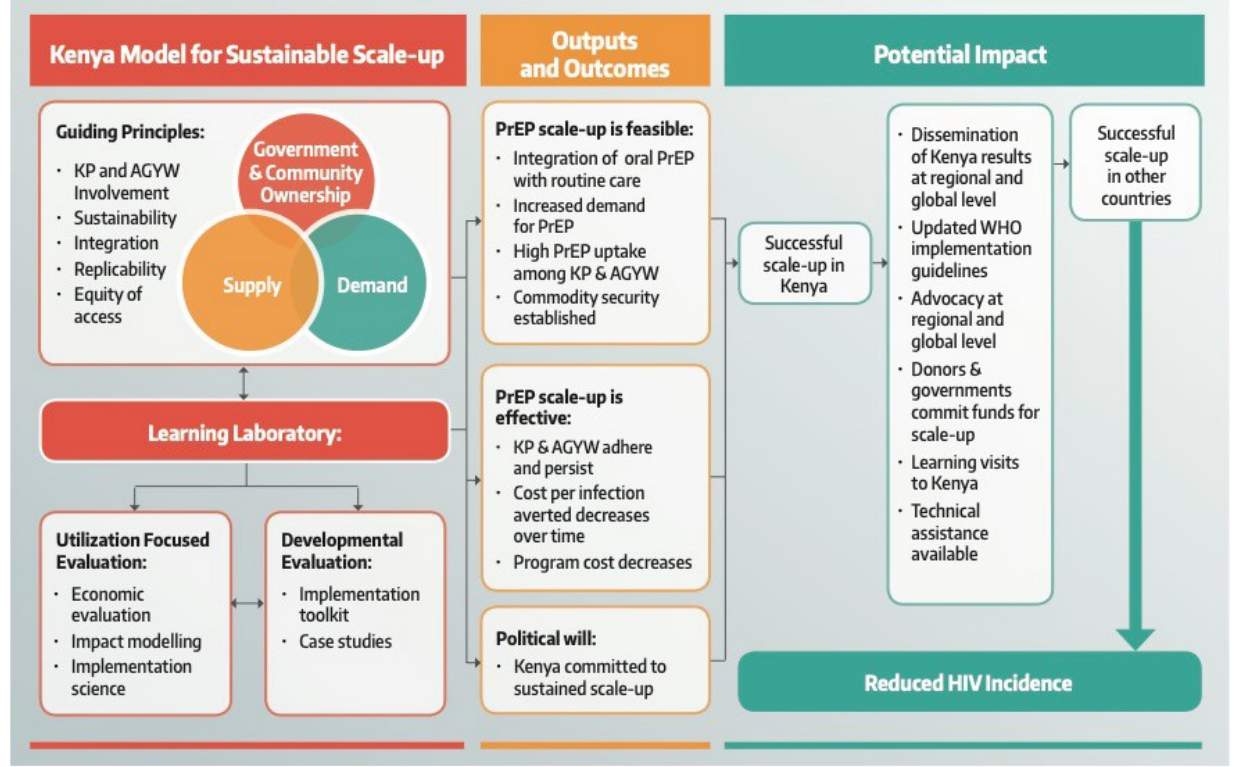
Figure 3. Jilinde project theory of change. (KP, key populations; AGYW, adolescent girls and young women; PrEP, pre-exposure